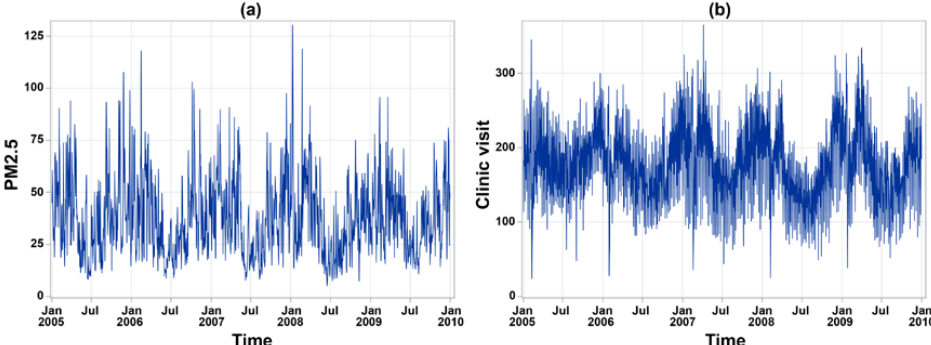
Figure 2. Trend plots of ( a ) daily PM 2.5 concentration and ( b ) daily clinic visits for children’s asthma averaged by district from 2005 to 2010.